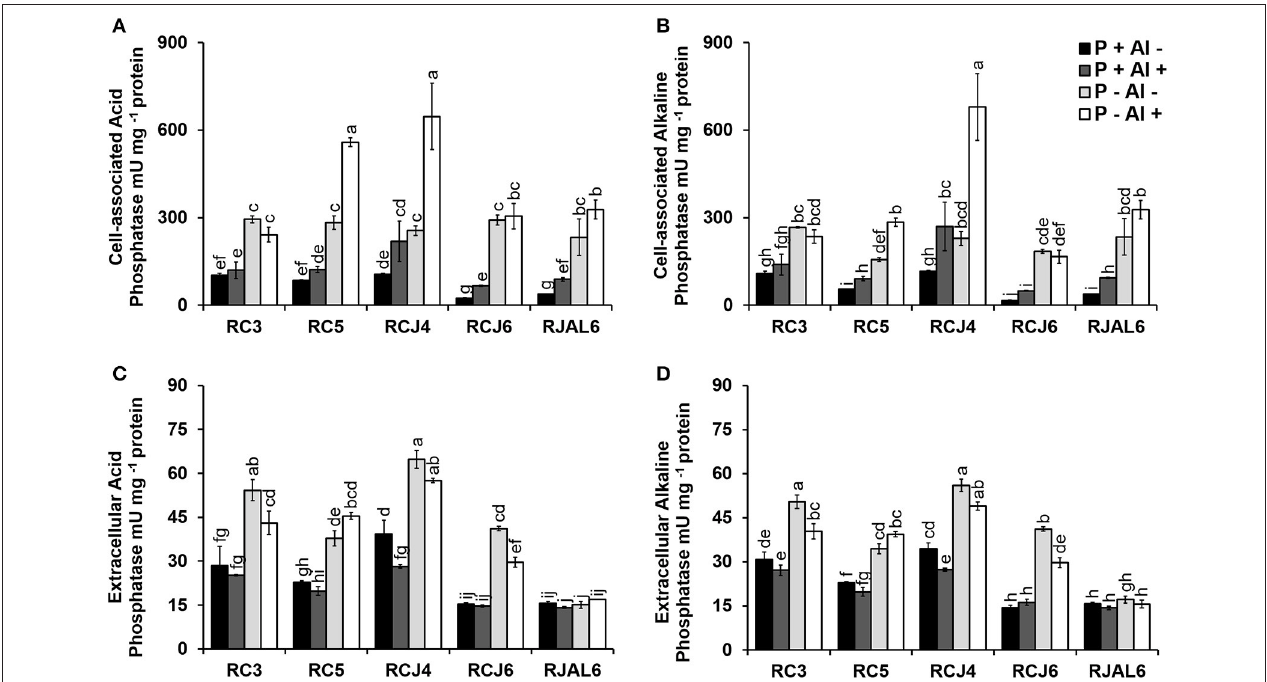
FIGURE 4 | Acid and alkaline phosphatase activity by five phosphobacteria Klebsiella sp. RC3, Stenotrophomonas sp. RC5, Klebsiella sp. RCJ4, Serratia sp. RCJ6, and Enterobacter sp. RJAL6 grown in a modified mineral culture medium (MCM) with contrasting P and Al concentrations. P + : 1.4mM KH 2 PO 4 ; P–: 0.05mM KH 2 PO 4 ; Al + : 10mM AlCl 3 × 6H 2 O; Al–: without Al added. (A) Cell–associated acid phosphatase, (B) cell–associated alkaline phosphatase, (C) extracellular acid phosphatase, and (D) extracellular alkaline phosphatase. Different letters on bars denote significant differences ( P ≤ 0.05; Tukey’s test) in phosphatase activity among treatments and